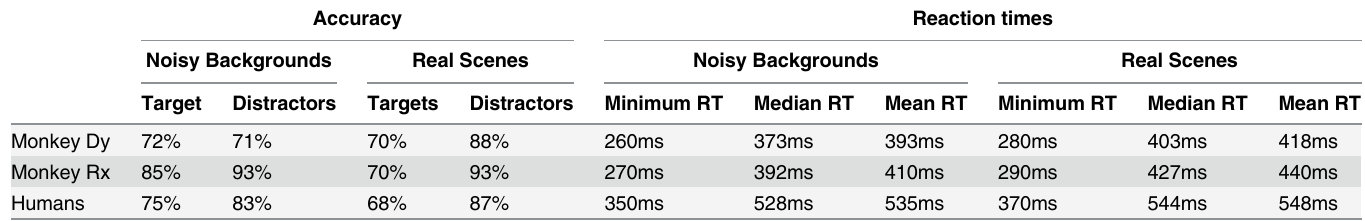
Table 1. Global performance of subjects in the two conditions.